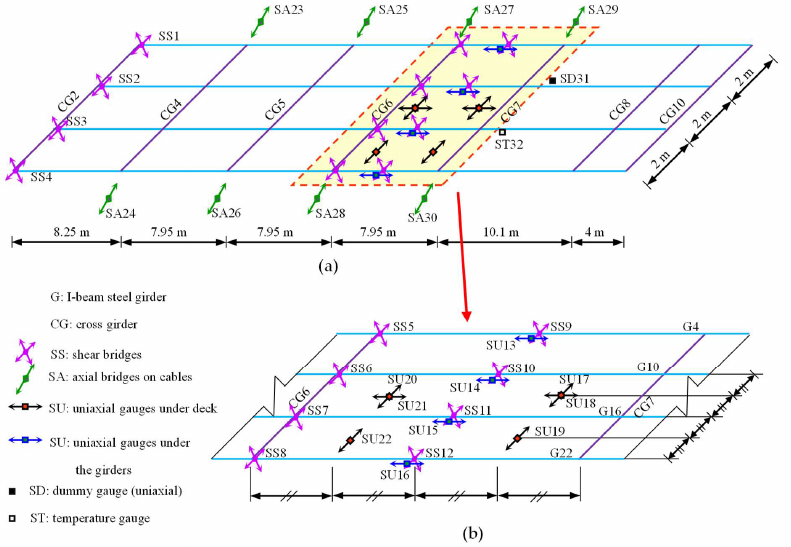
Figure 5. Illustration of the strain gauge array of the cable-stayed bridge structural health monitoring system. ( a ) The deck plan; ( b ) the strain gauge array between CG6 and CG7.